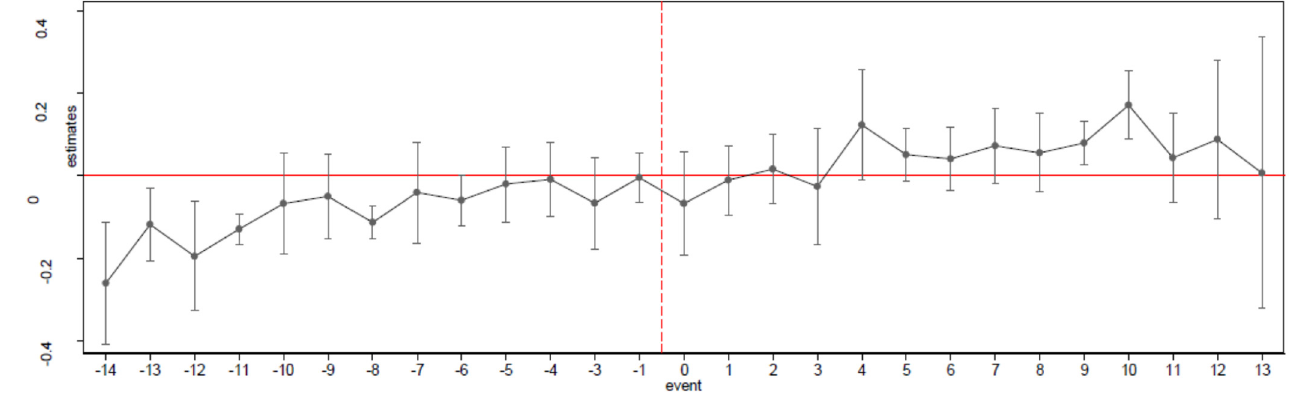
Figure 6. Parallel Trends Analysis – Event Studies on Loans Granted - Retail Sector.